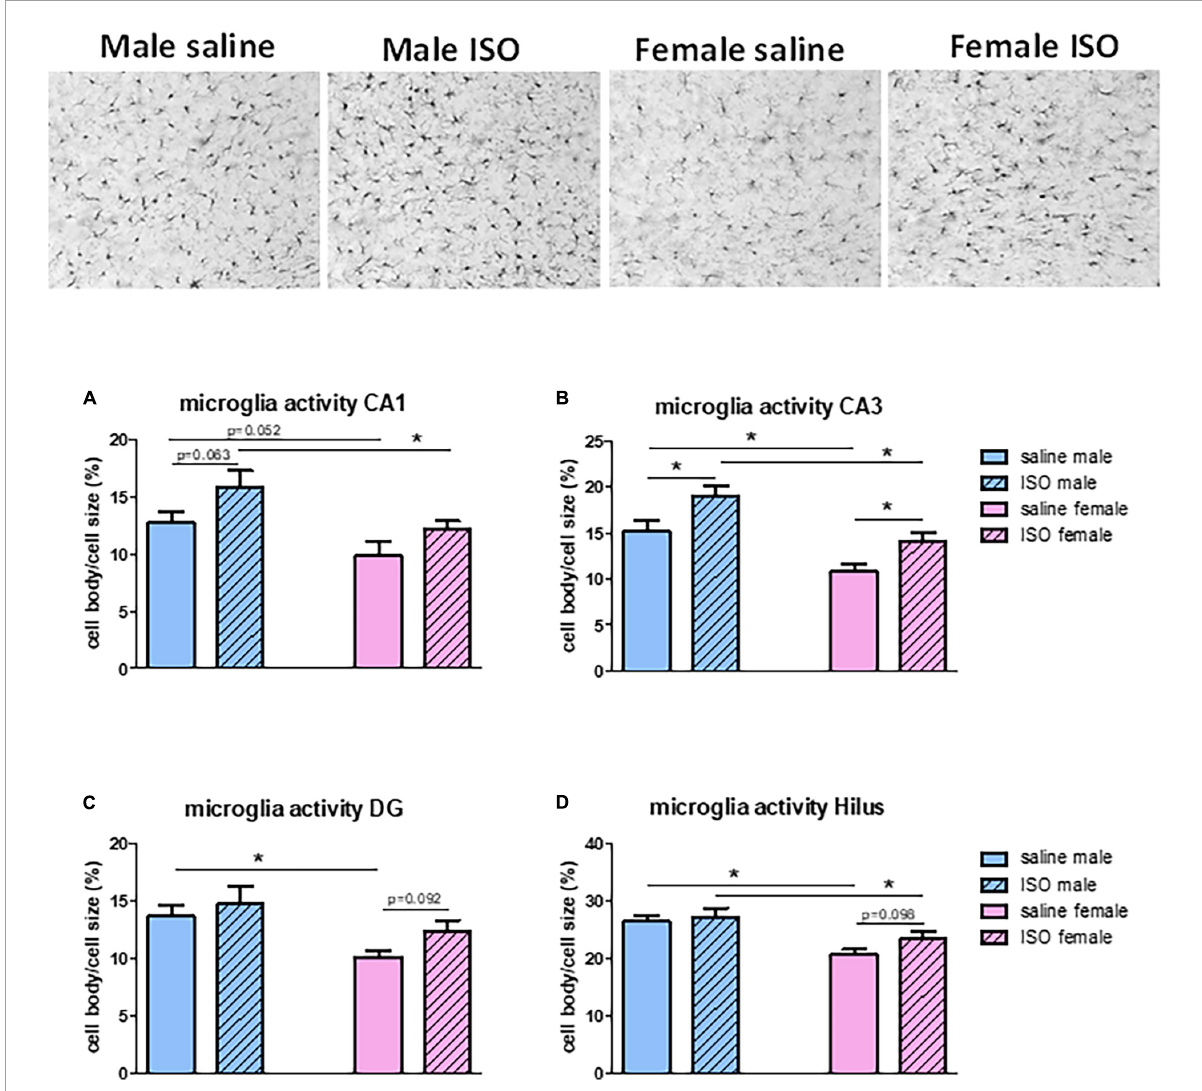
FIGURE4 Top: typical pictures of microglia in the hippocampal CA3 area of rats from the different experimental groups (200 × ). (A–D) Measurements of microglia activity in the different areas of the hippocampus, CA1, CA3, dentate gyrus (DG) and Hilus, in the different experimental groups ( n = 8,5,7,10 in saline male, ISO male, saline female and ISO female rats, respectively). ISO, isoproterenol. *Significant difference between indicated groups. Relevant tendencies with p < 0.1 are presented as